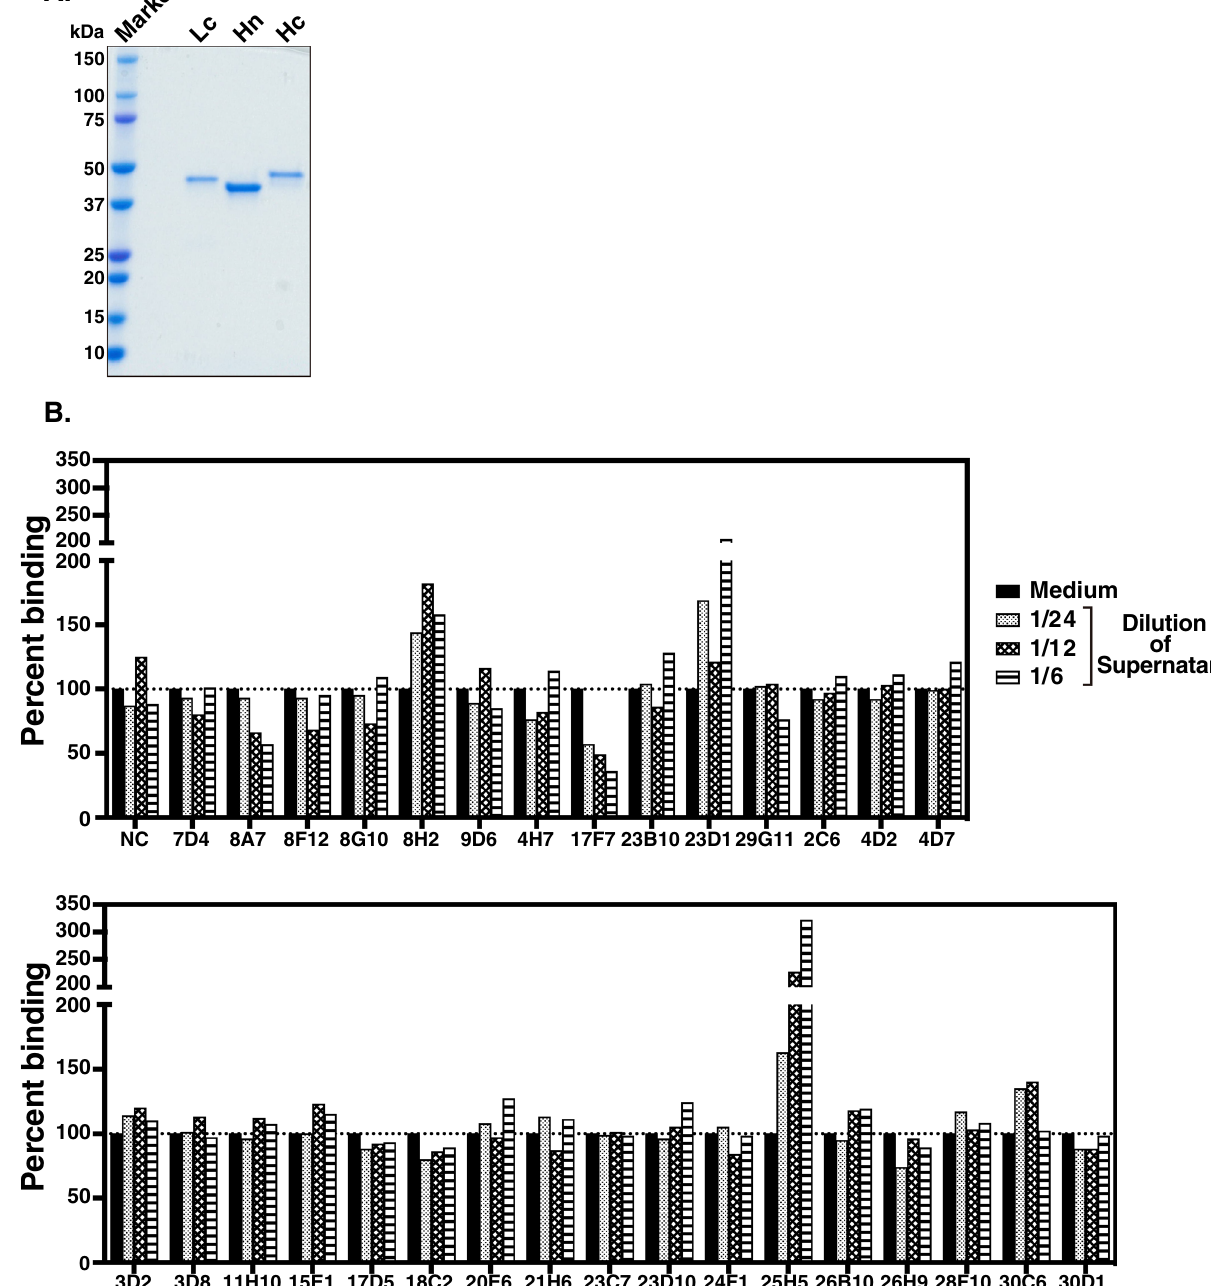
Figure 1. The 8A7 and 17F7 antibodies inhibit the binding of Hc to ganglioside GT1b. ( A ) The purified recombinant Lc, Hc, and Hn proteins were separated by 4–20% SDS-PAGE and stained with Coomassie Brilliant Blue (CBB). ( B ) The inhibition of Hc-GT1b by antibodies was analyzed by an ELISA-based Hc-GT1b binding assay. The supernatants of 31 Hc-reactive clones were serially diluted to 1/6, 1/12, and 1/24. Percent binding of Hc to GT1b is